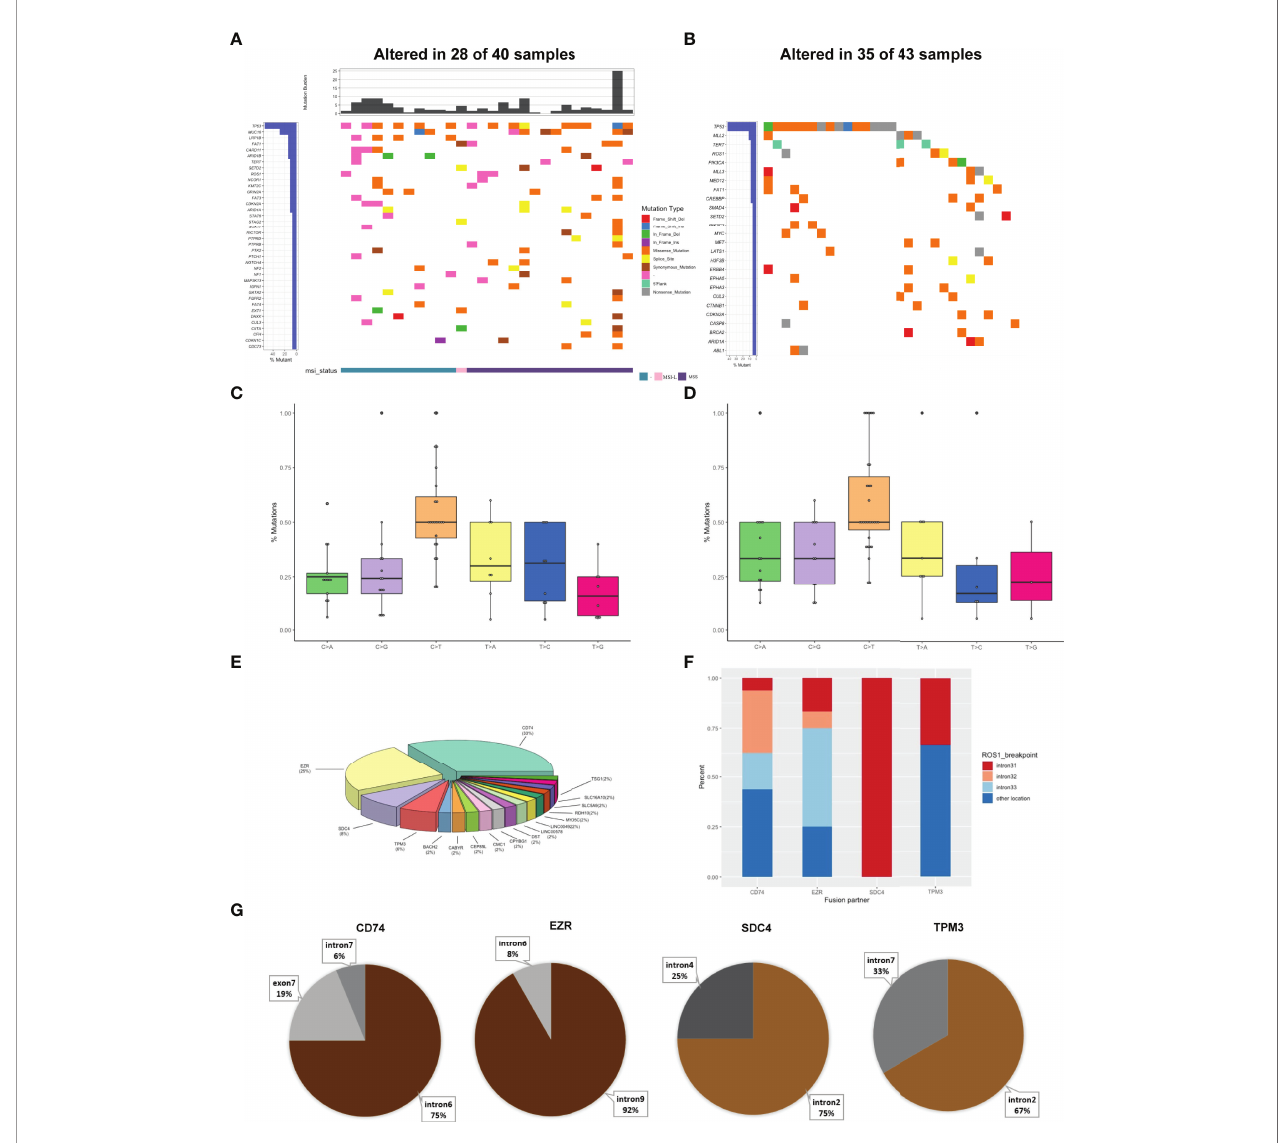
FIGURE 2 | Mutational pro fi les and partners of ROS1 fusion-positive patients. (A) The oncoprint of the somatic SNVs in 40 patients harboring ROS1 fusion in our study. (B) The oncoprint of the somatic SNVs in 43 patients harboring ROS1 fusion in the MSKCC database. (C) Mutational signatures of ROS1 fusion-positive patients in our cohort. (D) Mutational signatures of ROS1 fusion-positive patients in the MSKCC cohort. (E) Distribution of ROS1 fusion partners. (F) Distribution of fusion breakpoint positions in the most common ROS1 fusions including CD74-ROS1 , EZR-ROS1 , SDC4-ROS1 , and TPM3-ROS1 . (G) Distribution of breakpoint locations for ROS1 fusion partner genes, including CD74 , EZR , SDC4 , and TPM3